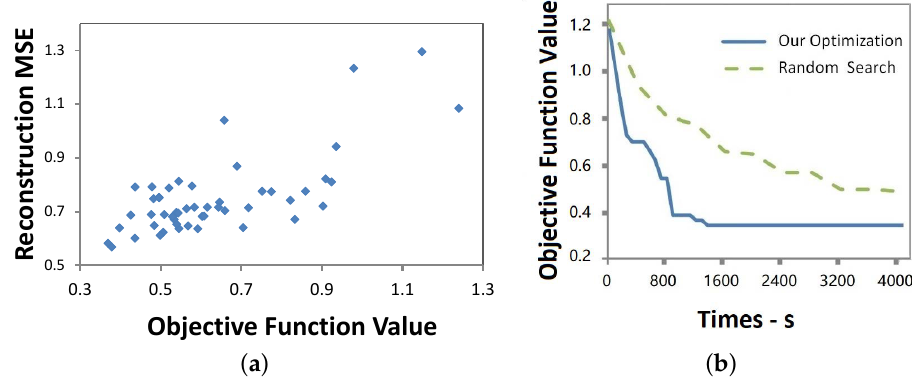
Figure 5. Estimated and actual errors Convergence rate ( a ) Relationship between objective function values and the actual reconstruction mean square error; ( b ) Comparison of convergence rates of the proposed search method and random